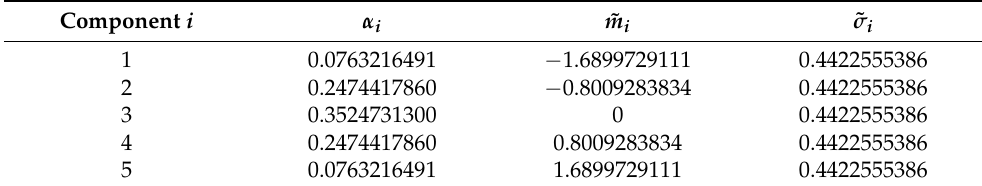
Table 2. Five-component splitting library with β = 2 and λ = 0.0025 [42] . Component i α